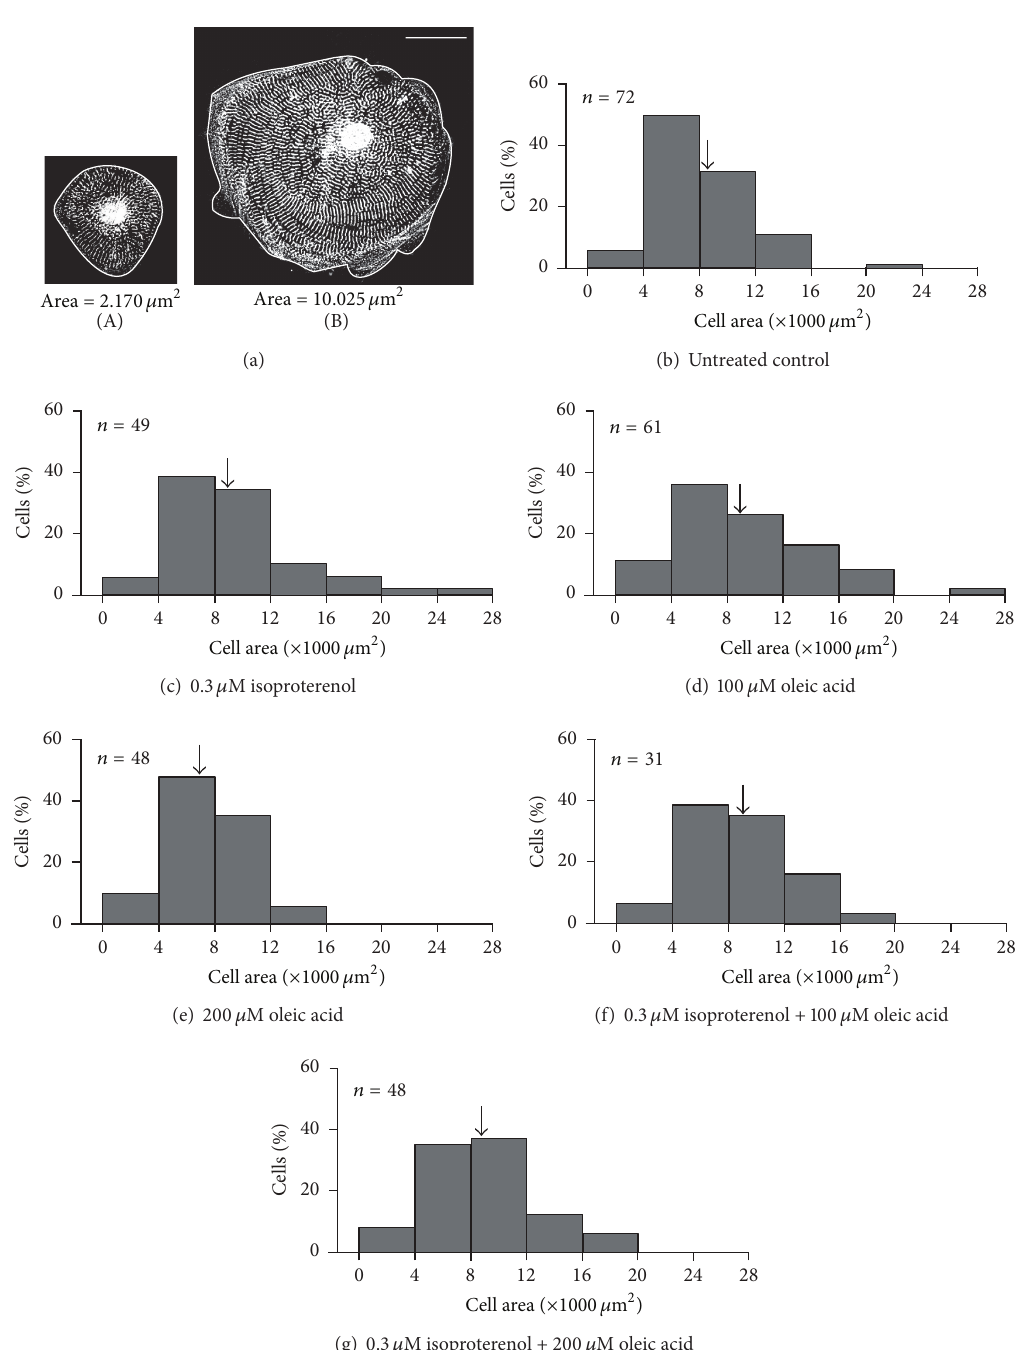
Figure 2: Effect of isoproterenol and oleic acid on the area of hESC-vCMs. ((a) panel (A), (a) panel (B)) Representative examples of the typical areas of hESC-vCMs measured. These two cells (labeled with an 𝛼 -actinin antibody) have cell areas of ((a) panel (A)) 2,170 𝜇 m 2 and ((a) panel (B)) 10,025 𝜇 m 2 , respectively. Scale bar is 30 𝜇 m. (b–g) Histograms to show the distribution of cells (in %) exhibiting a particular cell area in (b) untreated controls and (c–g) following treatment with (c) 0.3 𝜇 M isoproterenol, (d) 100 𝜇 M oleic acid, (e) 200 𝜇 M oleic acid, (f) 0.3 𝜇 M isoproterenol plus 100 𝜇 M oleic acid, or (g) 0.3 𝜇 M isoproterenol plus 200 𝜇 M oleic acid. The number of cells analyzed is indicated in the upper left corner of each graph. In all treatment groups, none of the area values was significantly different from those of the untreated controls. The arrows indicate the mean cell area determined for the population of